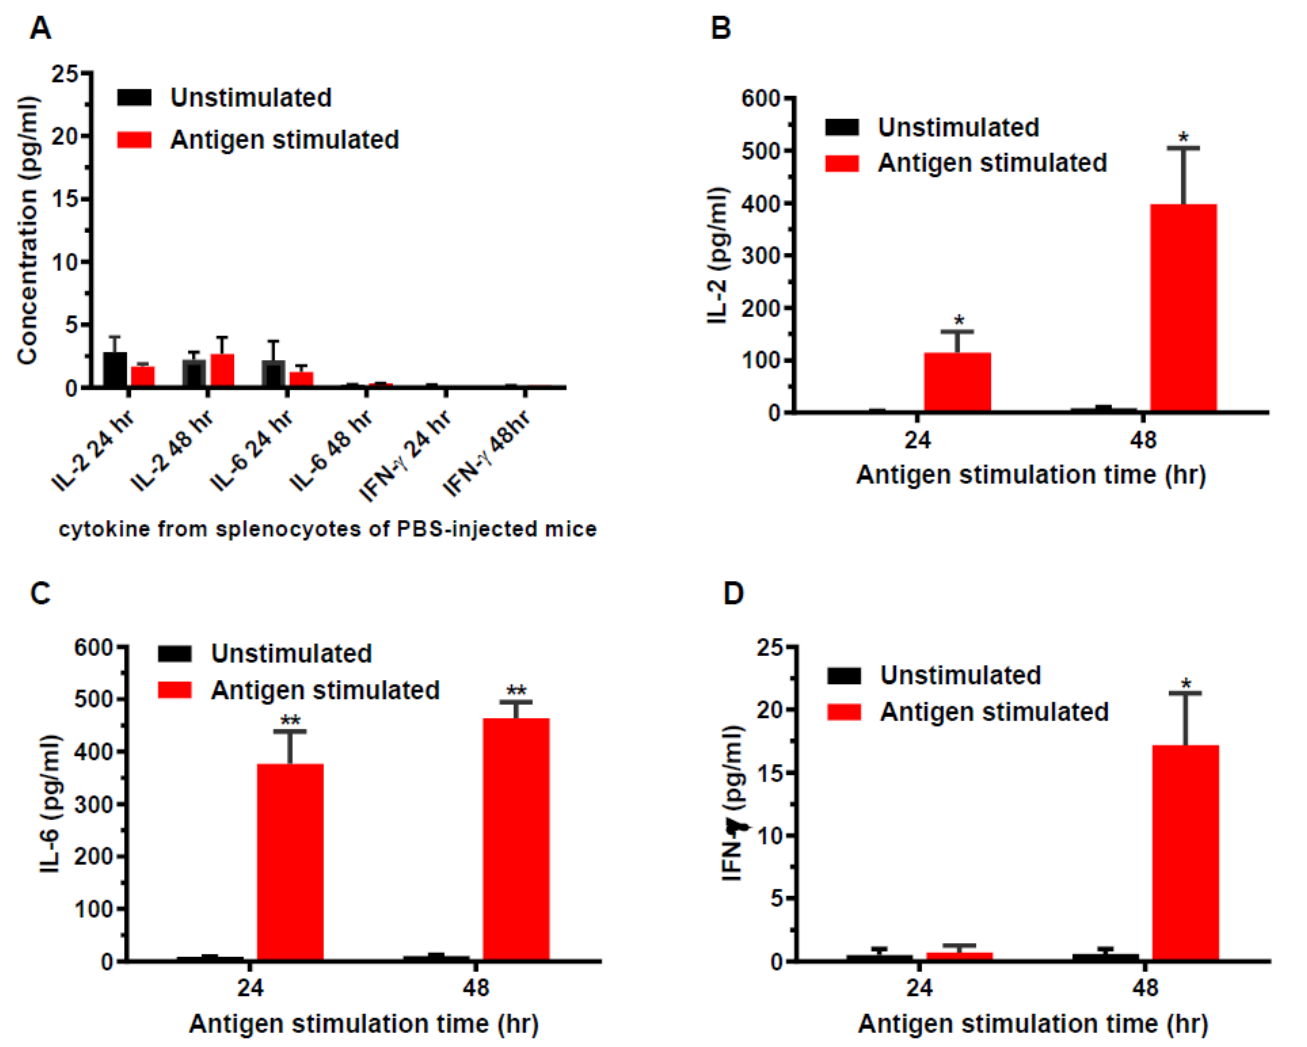
Figure 2. Cytokine production from splenocytes of immunized mice. Splenocytes isolated from mice mock-immunized with PBS (week 11) ( A ) or immunized with 25 µg HBcAg-wDIII VLP ( B – D ) were stimulated with wDIII or equivalent volume of culture media (unstimulated). After 24 or 48 h of stimulation, the levels of IL-2 ( A , B ), IL-6 ( A , C ), and IFN- γ ( A , D ) produced by splenocytes were quantitated. At least two independent experiments with technical triplicates were performed for each sample and the mean concentration (pg/mL) and SD are presented. Production of cytokines by antigen stimulation is statistically significant (compared to unstimulated samples, ** indicates p values < 0.0053 for IL-6, * indicates p values < 0.0174 for IL-2 24 h and 48 h, and for IFN- γ 48 h). The differences in cytokines levels between splenocytes of HBcAg-wDIII VLP-vaccinated and PBS-injected mice are also significant ( p < 0.0112 for IL-2; p < 0.0120 for IL-6; and p < 0.0171 for IFN- γ ). No significant difference in levels of cytokines was detected between unstimulated and wDIII-treated splenocytes from PBS-infected mice ( p >